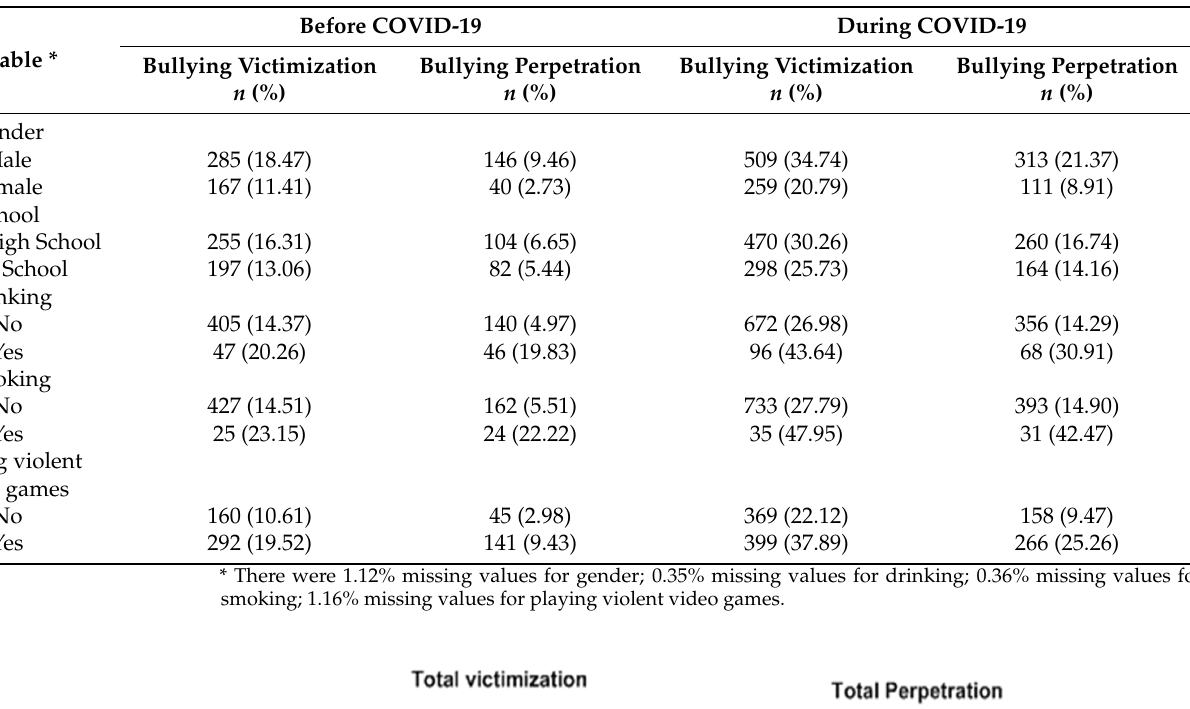
Table 1. Comparison of the prevalence of overall bullying victimization and bullying perpetration by different variables before and during the pandemic.